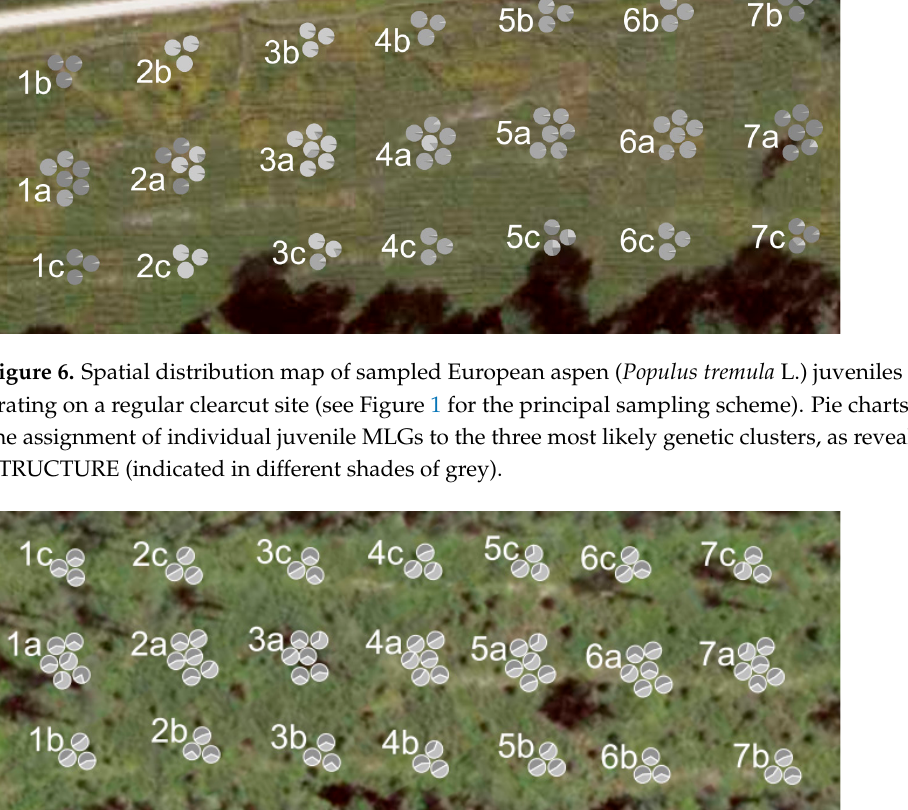
Figure 7. Spatial distribution map of sampled black alder ( Alnus glutinosa (L.) Gaertn.) juveniles regenerating on a regular clearcut site (see Figure 1 for the principal sampling scheme). Pie charts show the assignment of individual juvenile MLGs to the two most likely genetic clusters, as revealed by STRUCTURE (indicated in different shades of grey).